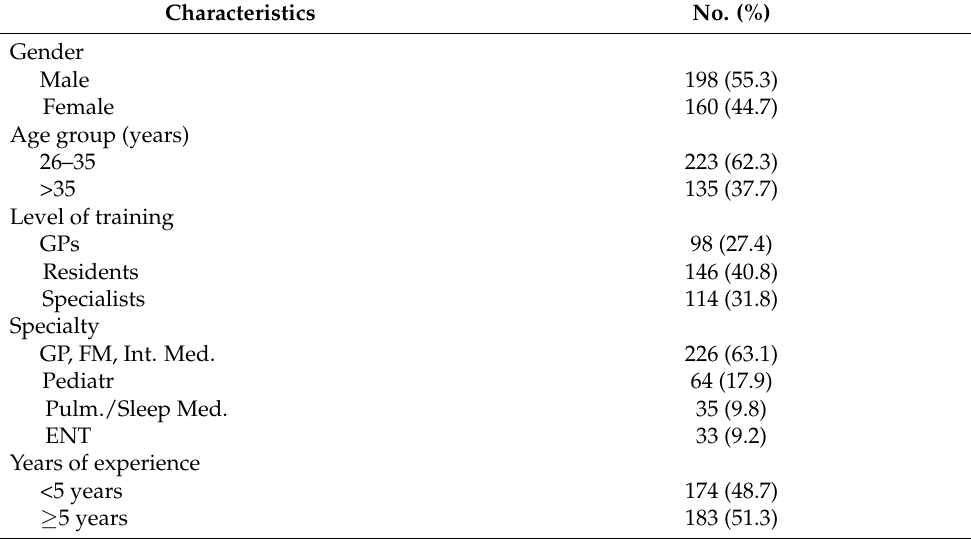
Table 1. Personal characteristics of physicians ( n =